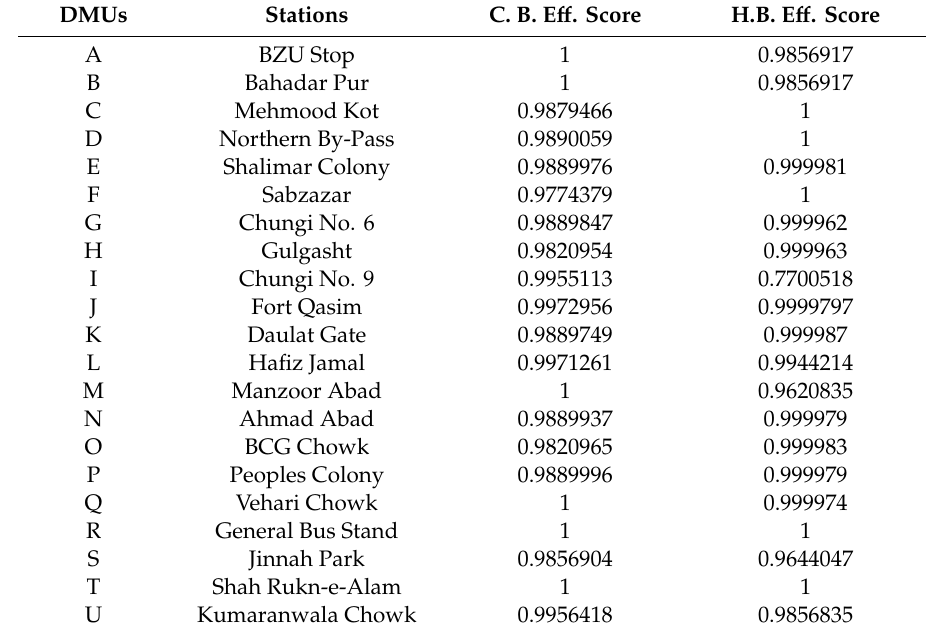
Table 2. Comparative Performance Analysis of Conventional Fuel Bus vs. Hybrid Fuel Bus System Analysis.